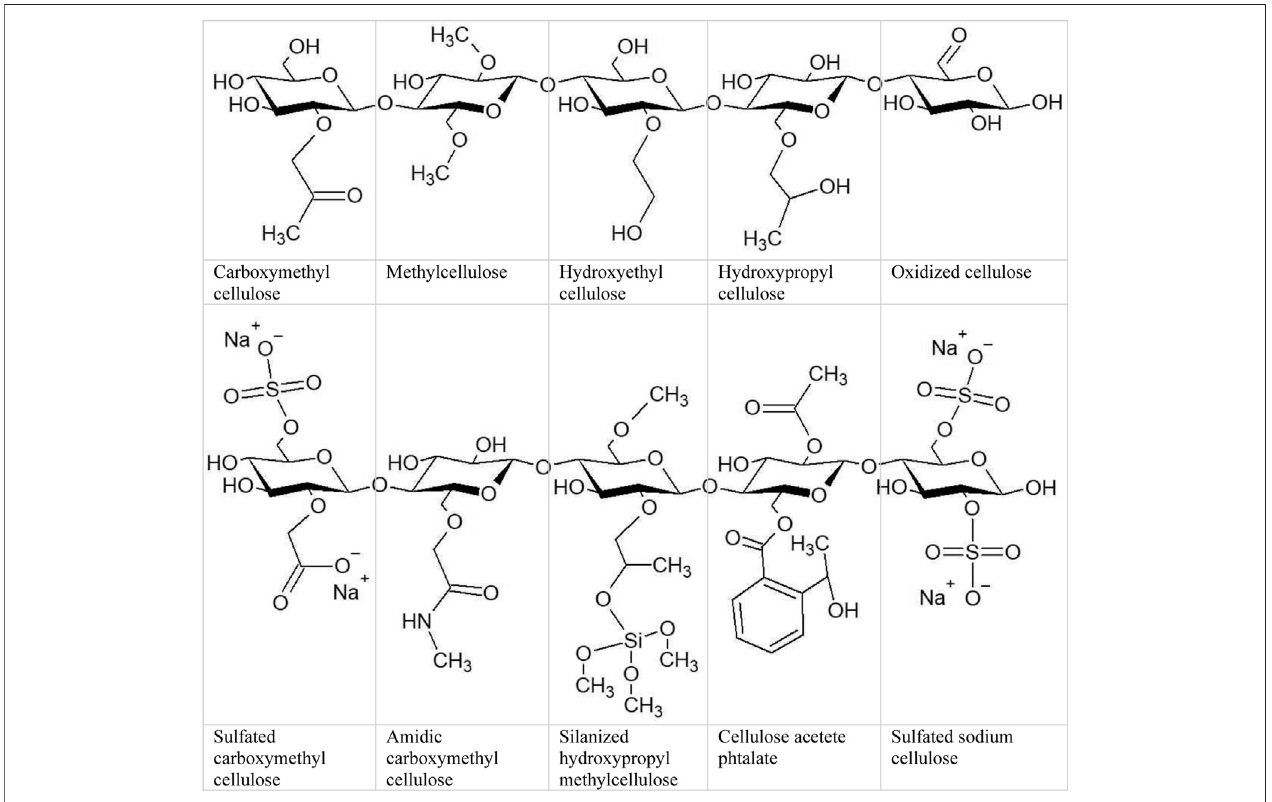
FIGURE 5 | Cellulose and its derivatives. Hydroxyl groups connected with carbon 2, 3 and/or 6 allows to formation esters or ethers bonds in variable ratio.